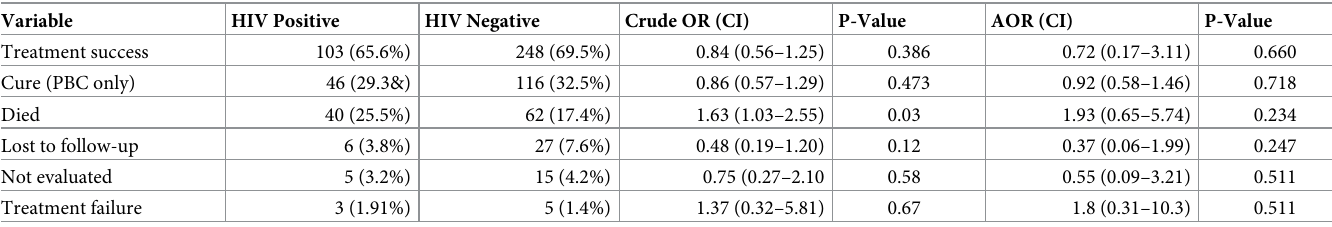
Table 5. Treatment outcomes among elderly Hiv-positive TB patients.